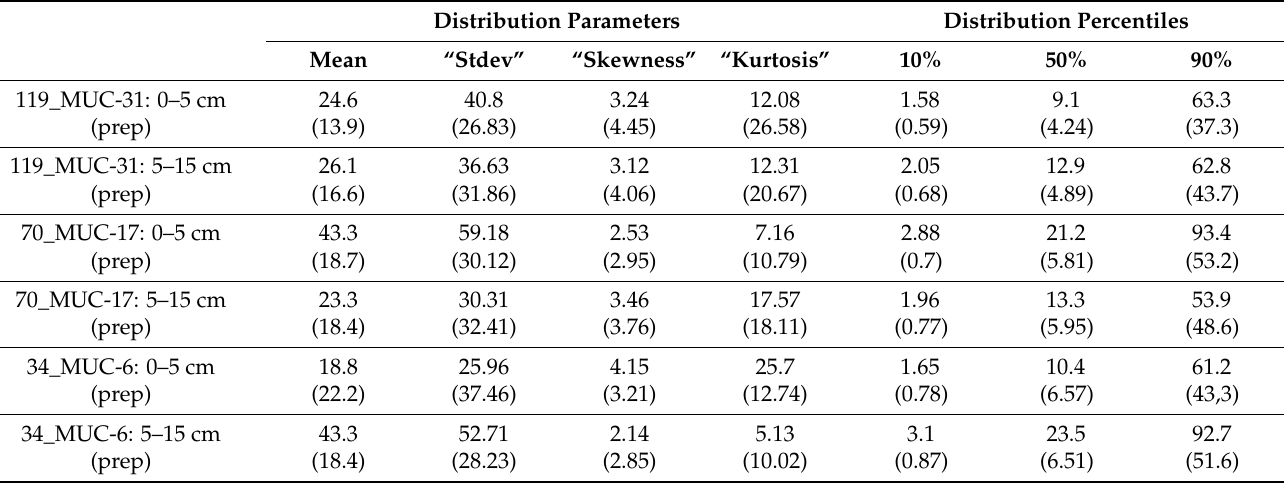
Table 2. Particle size distribution metrics for the surface sediment layer of the selected 6 multicores. Values between brackets represent pre-treated samples, from which flocculi, carbonates and Fe-Mn oxides have been